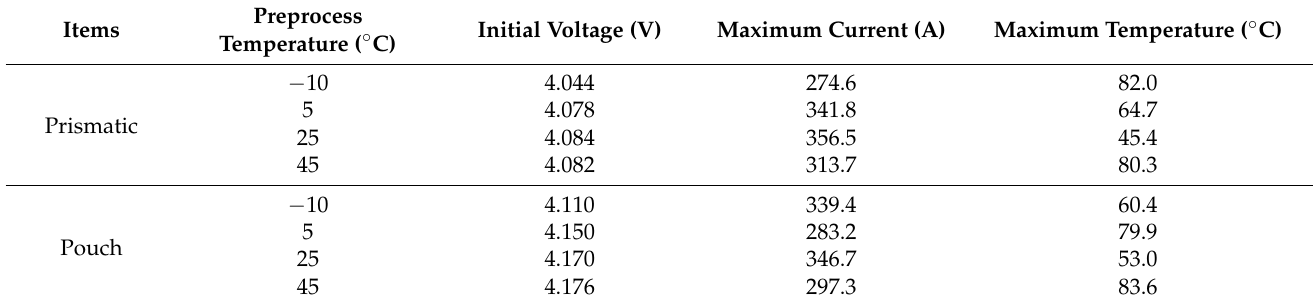
Table 6. Characteristics of external short circuit with preprocessing